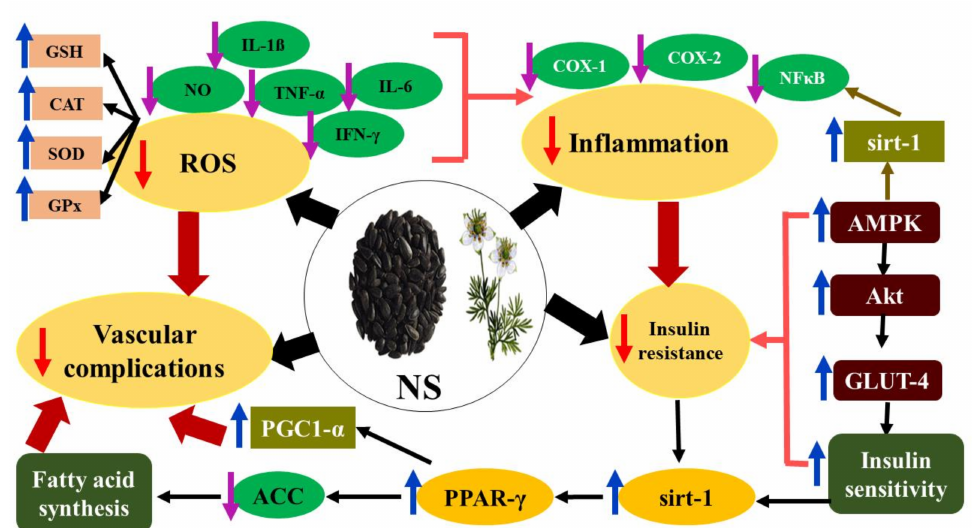
Figure 5. The molecular mechanistic pathways of antidiabetic effect of NS. GSH: reduced